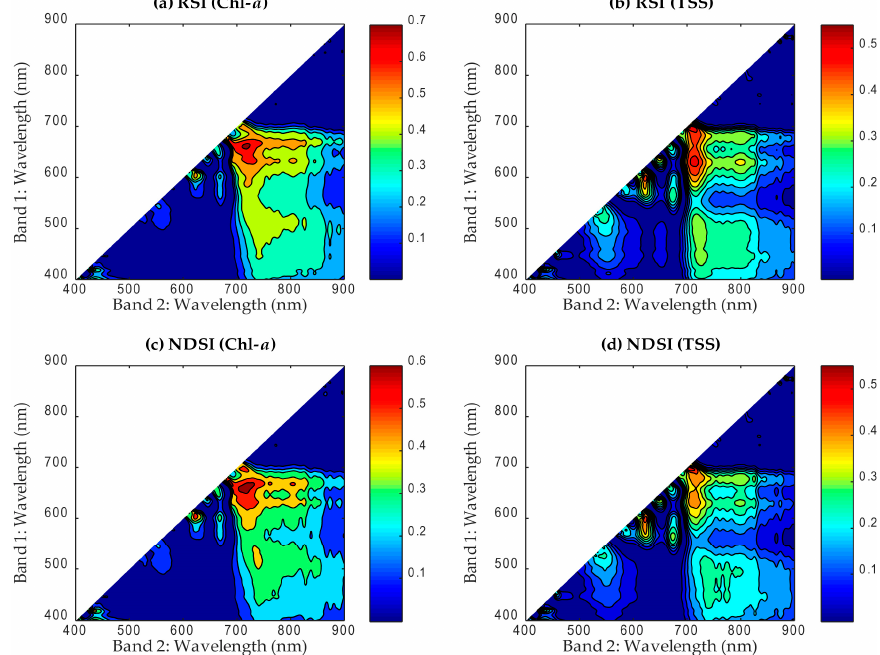
Figure 3. Distributions of R 2 between two wavebands using RSI ( a ) Chl- a ; ( b ) TSS and NDSI ( c ) Chl- a ; ( d ) TSS.